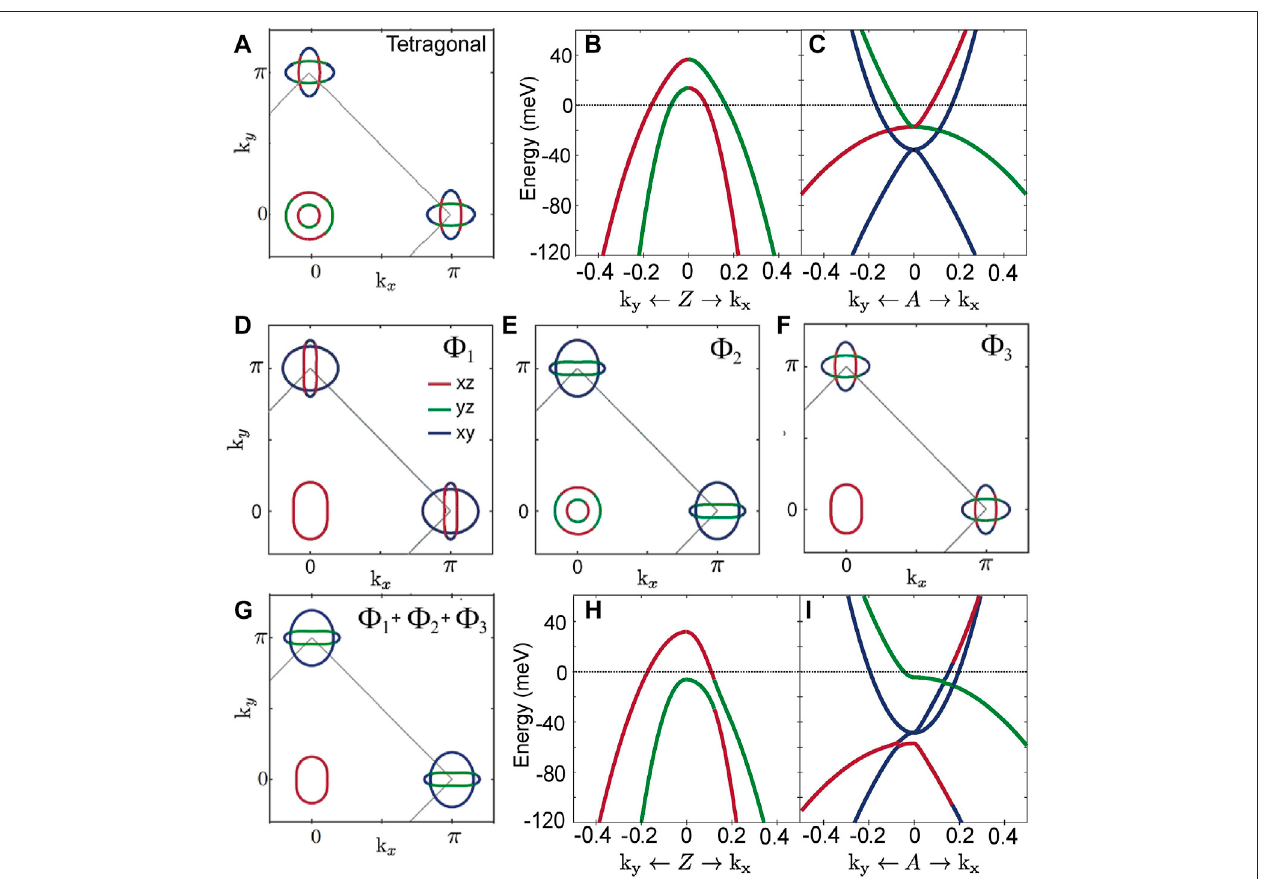
FIGURE6| Limitationsof d xz / d yz nematicorderingandoriginofthemissingelectronpocketproblem. (A,B,C) FermisurfaceandbanddispersionsaroundtheZand A point, for a tetragonal state model of the electronic structure from Ref. [67] in quantitative agreement with ARPES measurements. (D,E,F) The individual effect of the threesymmetrybreaking d xz / yz nematicordertermsontheFermisurfaceofthetetragonalstatemodel. (D) Ferroorbitalorder( Φ 1 =26 meV) (E) d-wavebondorder( Φ 2 = − 26 meV) (F) Extendeds-wavebondorder( Φ 3 =15 meV). (G,H,I) FermisurfaceandbanddispersionsaroundtheZandApoint,usingacombinationof Φ 3 as isoften used in the literature. No matter what linear combination of these order parameters are used, a Fermi surface in agreement with the experimental data can not be